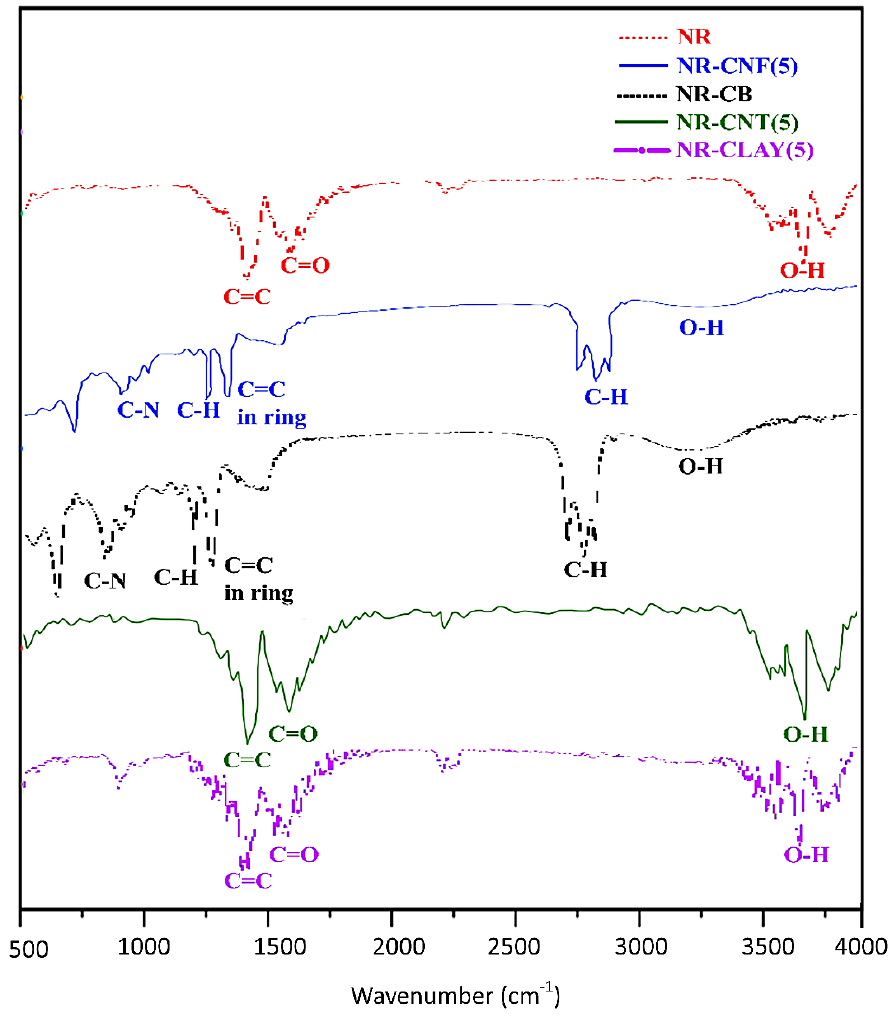
Figure 5. FTIR image of NR with different fillers CNT/CNF/CB/CLAY.